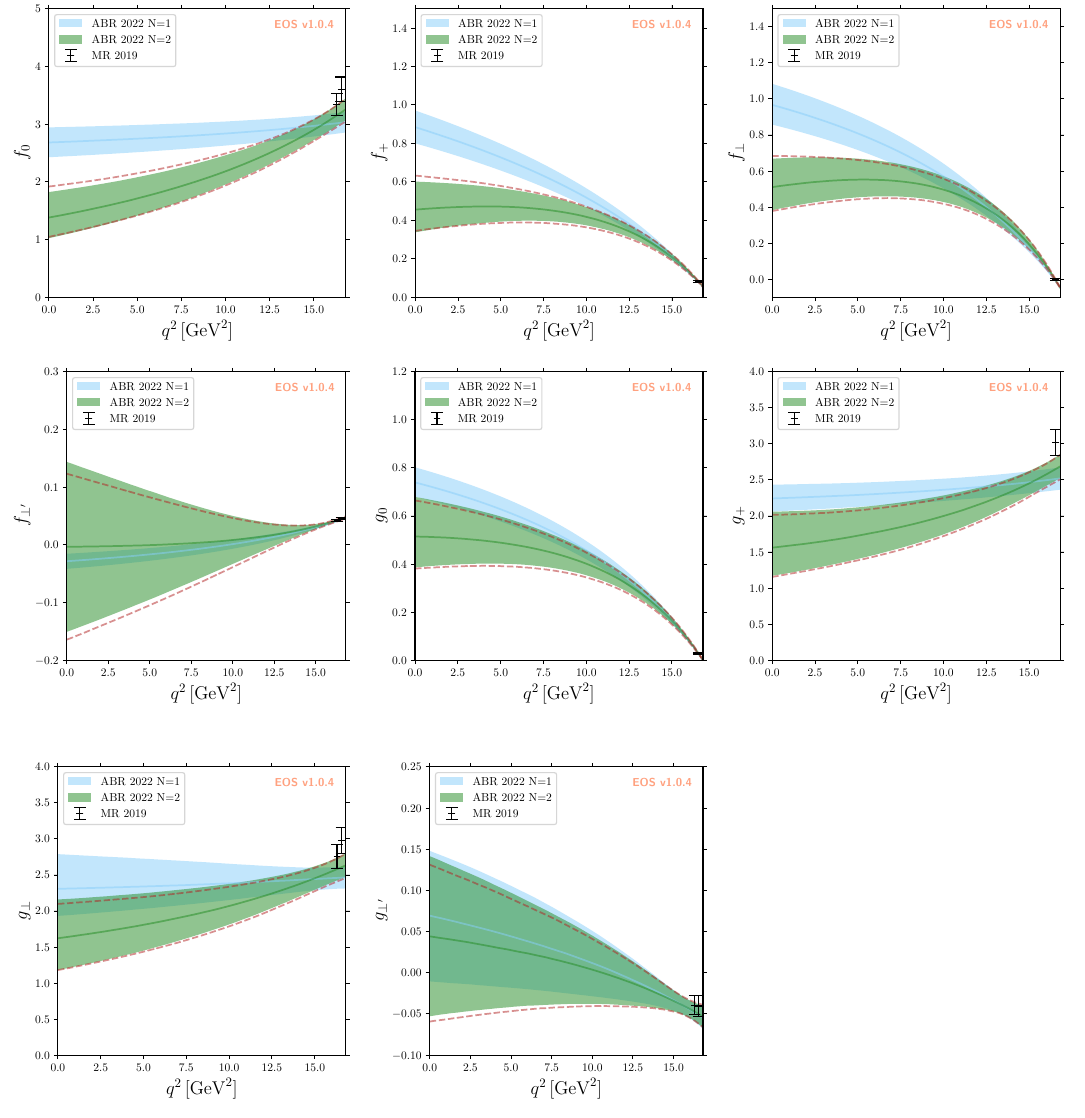
Figure 2 . Fit results for the vector and axial-vector Λ b → Λ(1520) form factors. The blue and green bands are the 68% C.L. region, and the solid line shows the median of the distribution for N = 1 and N = 2 , respectively. The dashed red lines contain the 68% C.L. region for the N = 3